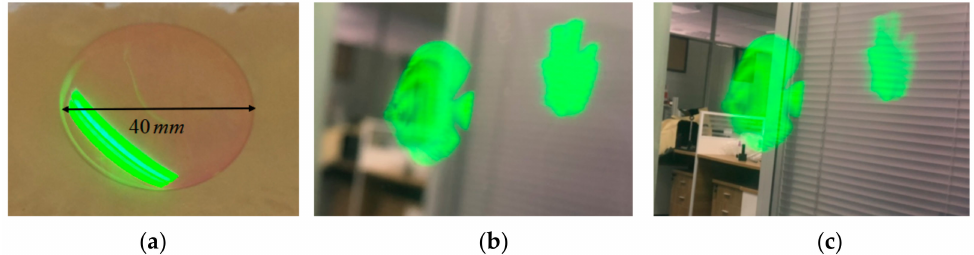
Figure 11. Optical experiment results. ( a ) Fabricated HOE; ( b ) Focused on Fish (1.2 m); ( c ) Focused on coral (3